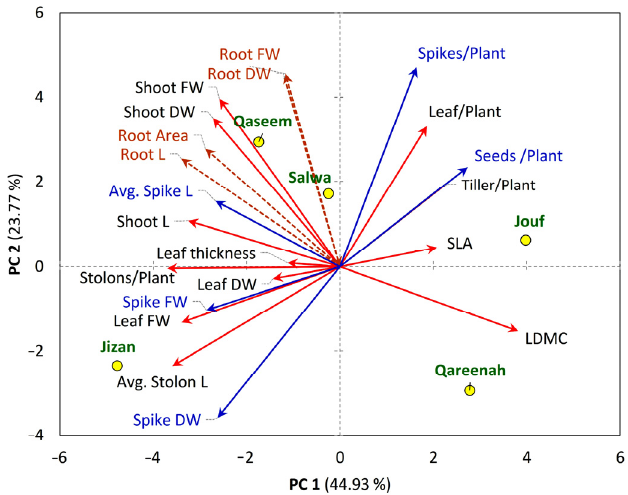
Figure 8. Principal component analysis (PCA) of the measured traits (shoot, represented with red arrows, root represented with brown arrows, reproductive traits represented with blue arrows of Aeluropus lagopoides within different saline flat regions (represented with yellow circle) of Saudi